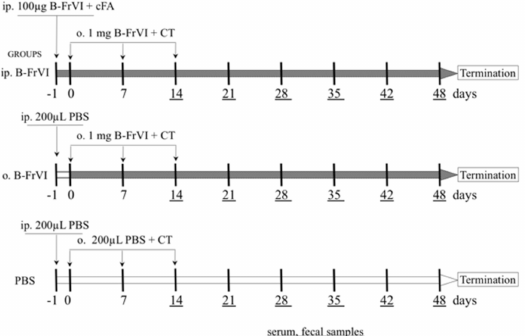
Figure 1. Animal experiment scheme. Abbreviation: o. − oral immunization; ip. − intraperitoneal immunization; B − FrVI − barley fraction VI